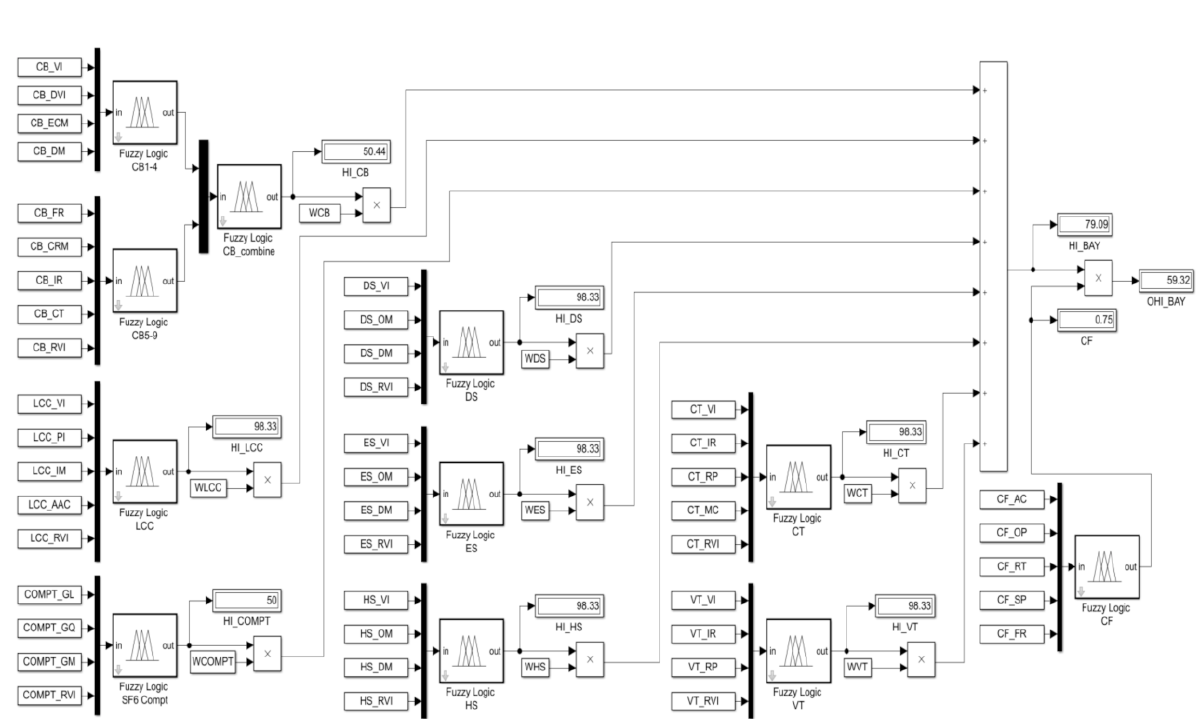
Figure A1. Fuzzy logic model for health index determination of case study